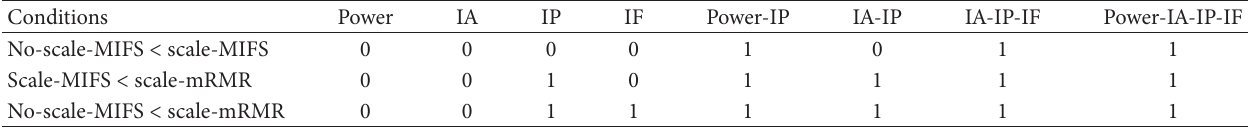
Table 2: The 𝑡 -test comparison between different feature processing methods using ELMs (the confidence level is 0.01).